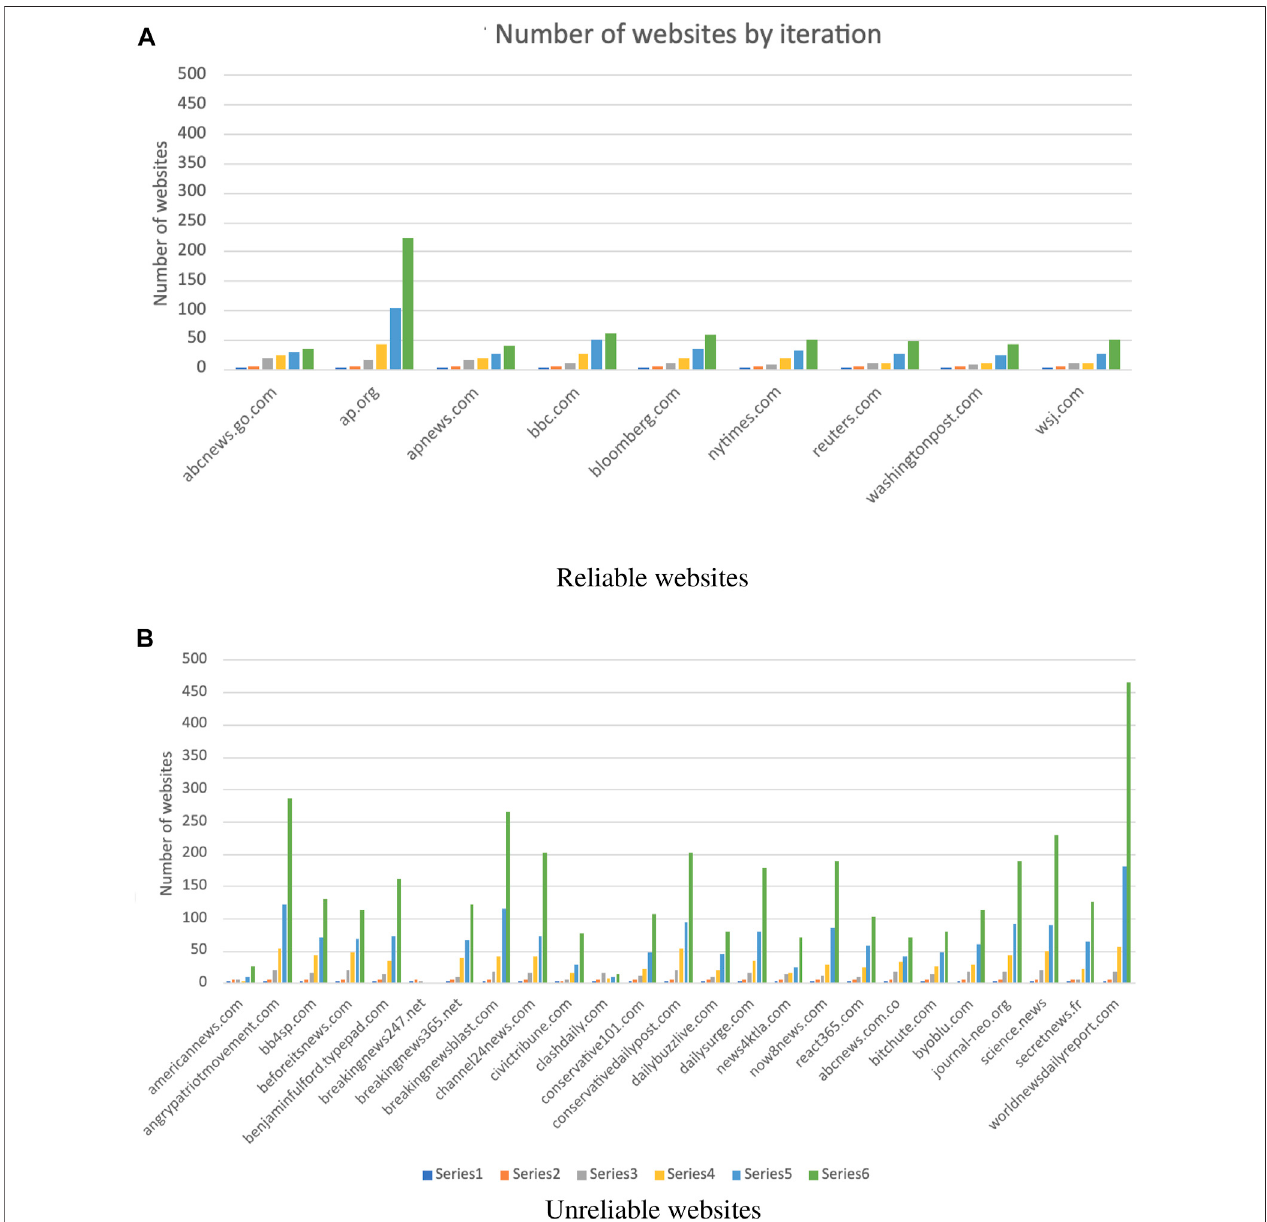
FIGURE 10 | Sub-networks growth by iteration. The charts show the number of websites ( y -axis) collected at each iteration (series) using the AO tool. The comparison of unreliable sub-networks and reliable sub-networks growth rates showed that the growth rate of the reliable sub-networks is lower than that of the unreliable sub-network through the iterations (A) Reliable websites. (B) Unreliable